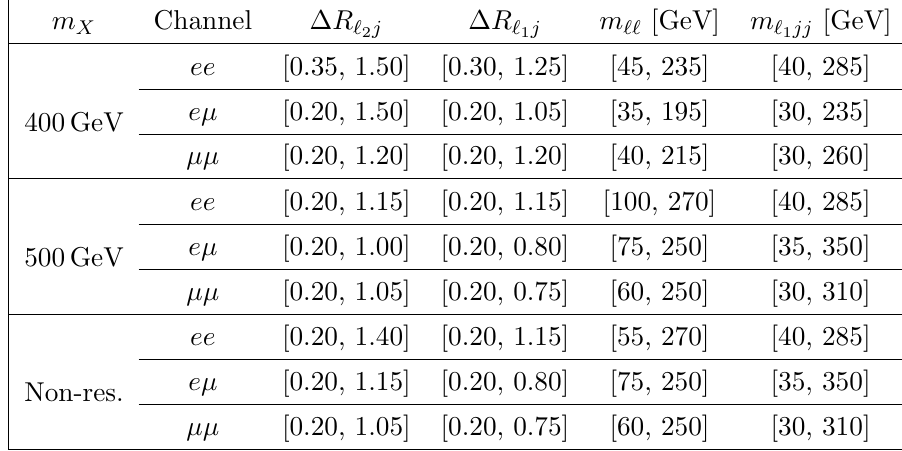
Table 5 . Optimised selection criteria used in the two lepton channel in the non-resonant HH search and the X ! HH search with m X = 400 GeV and m X = 500 GeV.